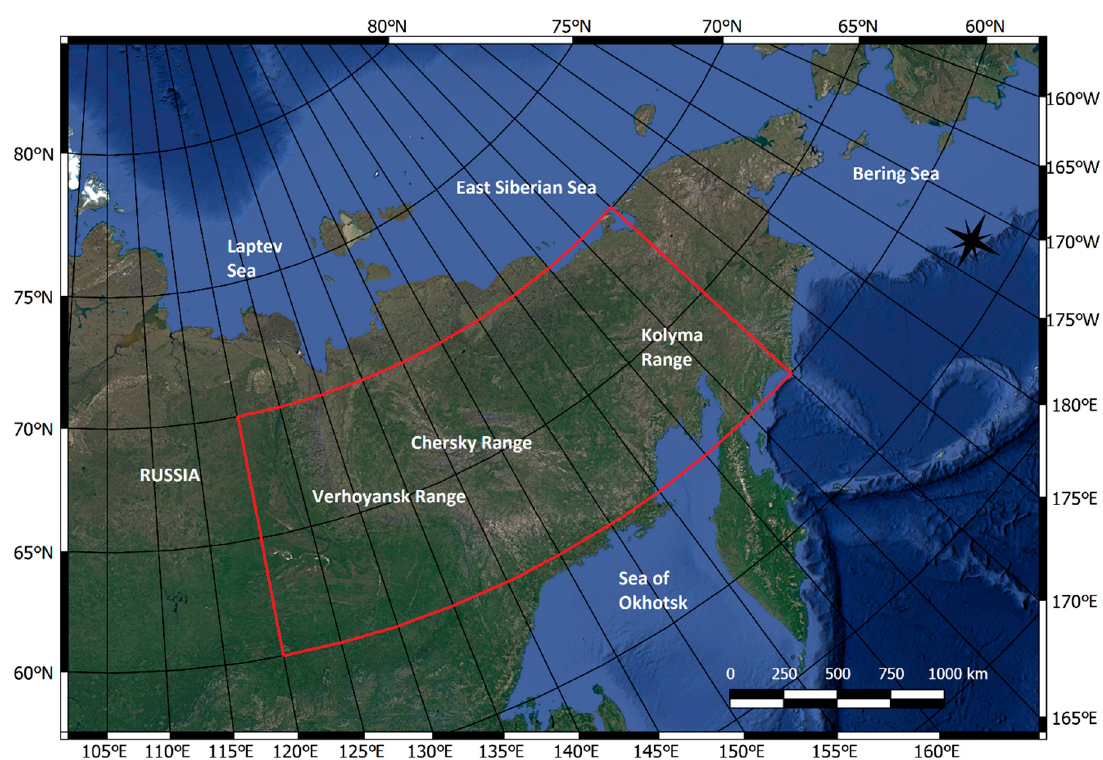
Figure 1. The Northeastern Siberia study region (70 ◦ N, 120 ◦ E; 60 ◦ N, 170 ◦ E). Boreal forest (green) is differentiated from all the other land covers (brown) and water bodies (blue).